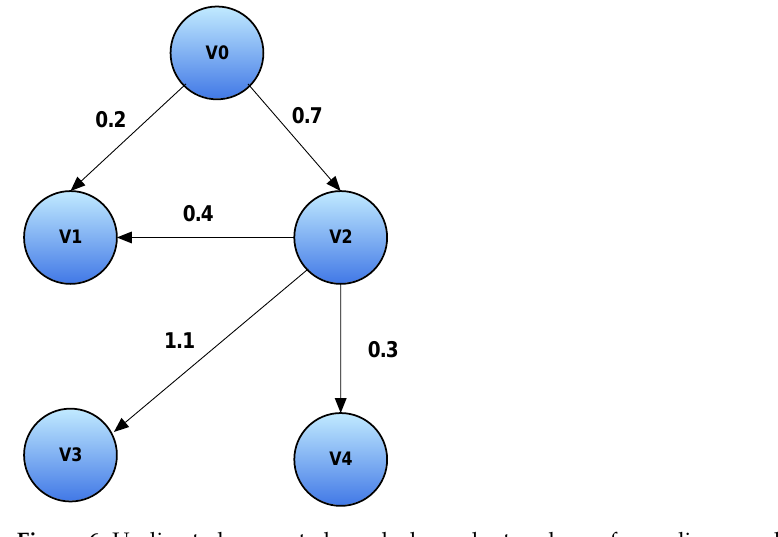
Figure 6. Undirected connected graph shown by topology of a nonlinear multi-agent